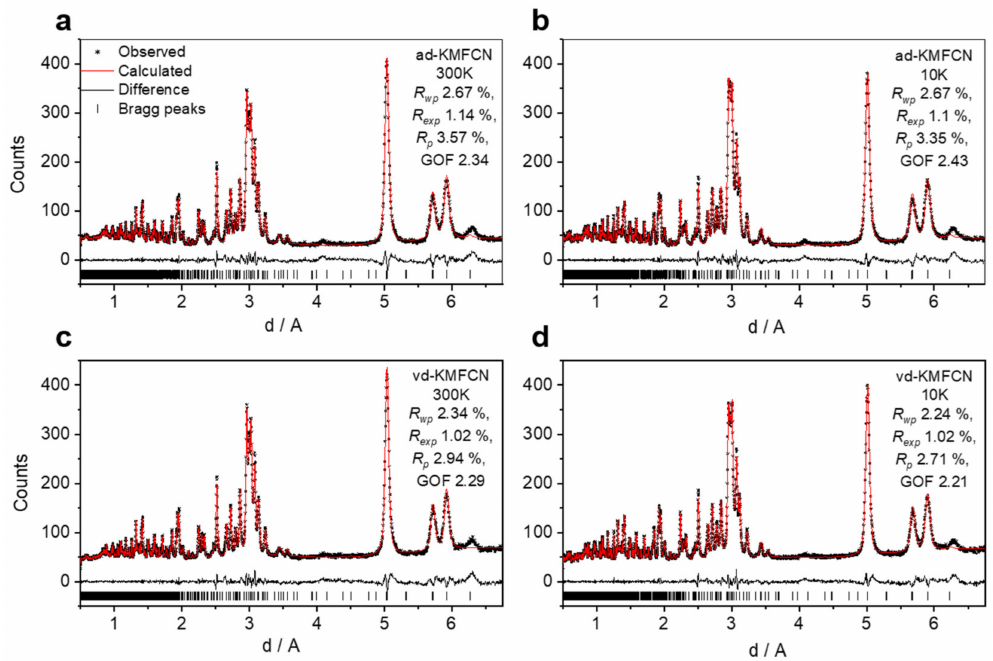
Figure 2. Experimental, calculated, difference and theoretical neutron diffraction patterns of ad-KMFCN collected at ( a ) 300 K and ( b ) 10 K, and vd-KMFCN collected at ( c ) 300 K and ( d ) 10 K. Joint refinement indices are R wp 2.5%, R exp 1.07%, R p 3.11%, and GOF 2.30.